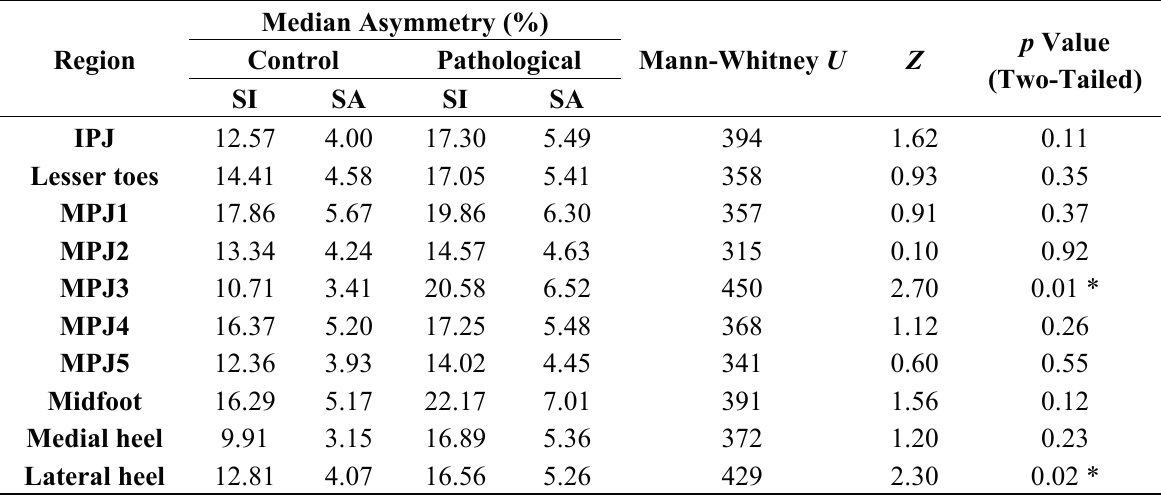
Table 3. Assessment of median asymmetry percentage in control and pathological groups for Mann-Whitney U tests per region of interest. Significant results are indicated with an asterisk (*).